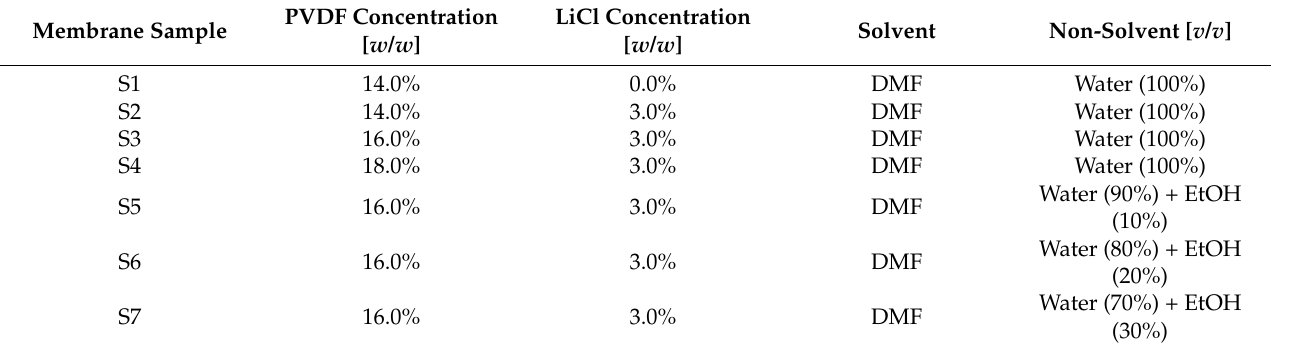
Table 1. Experimental conditions for membrane